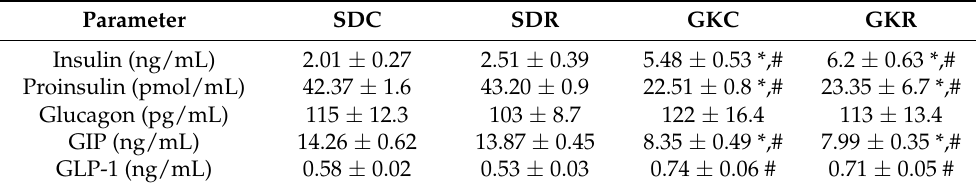
Table 1. Effects of resveratrol on blood hormone levels in SD and GK rats.